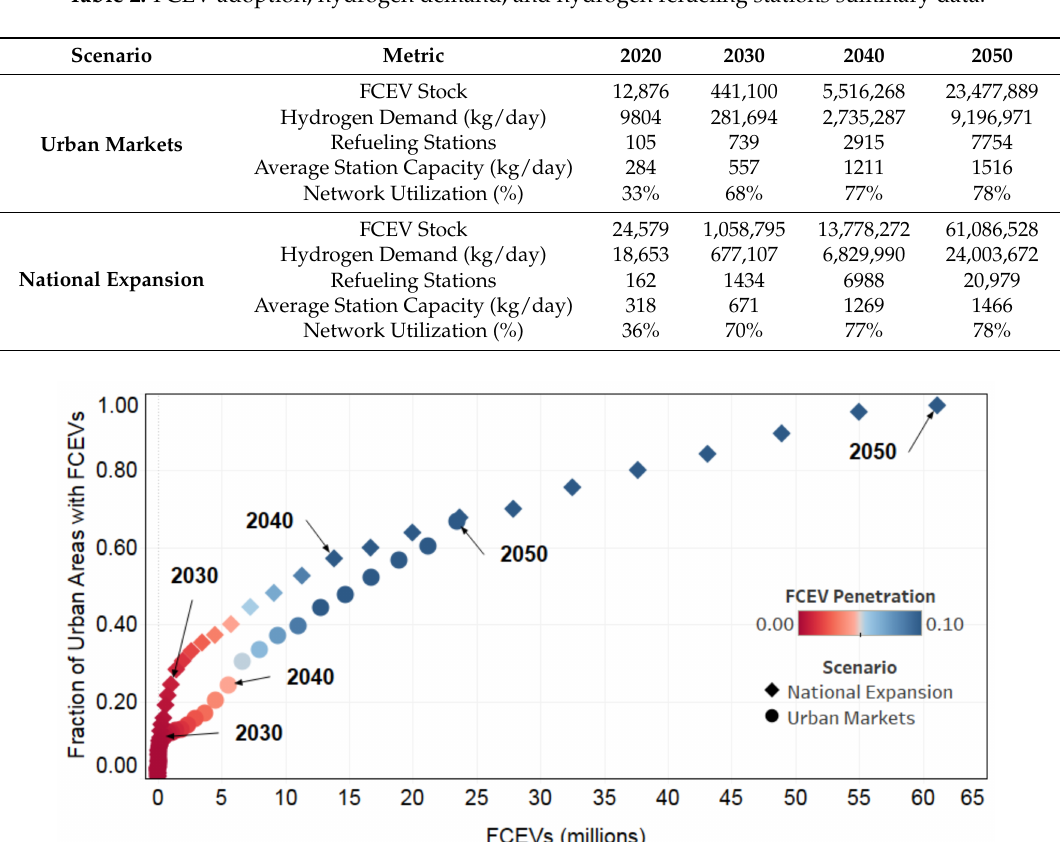
Figure 7. Number of urban areas with FCEVs over time for each scenario. Color indicates the average fraction of FCEV penetration over all urban